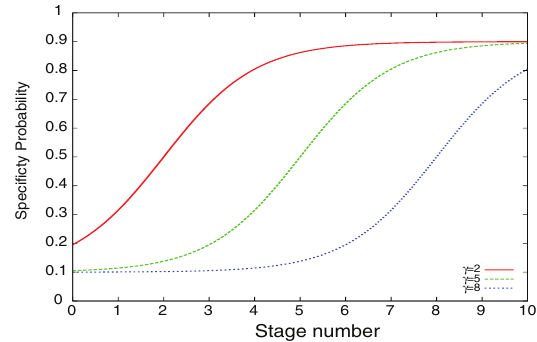
Figure 9. A nonlinear specificity function, s ( l ) = 0.9 − 0.8 / (1 + e γ −l ), for three values of the parameter γ . This function allows us to control the stage γ at which the specificity is